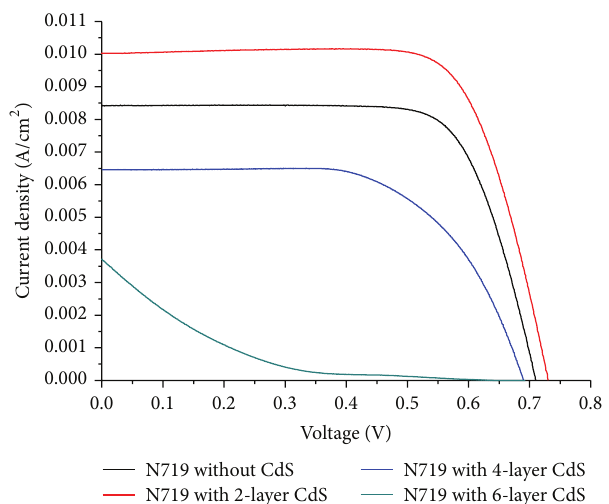
, 𝑉 , FF, and efficiency with different CBD cycles. sc oc